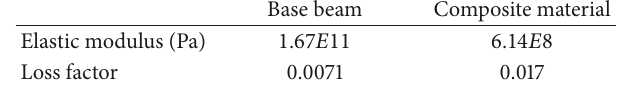
Table 3: Initial material properties.